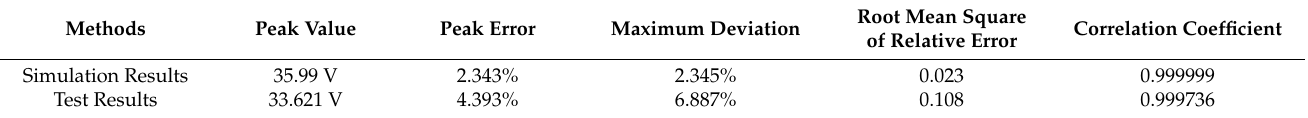
Table 2. Comparison of motor back EMF obtained by simulation results and test results.